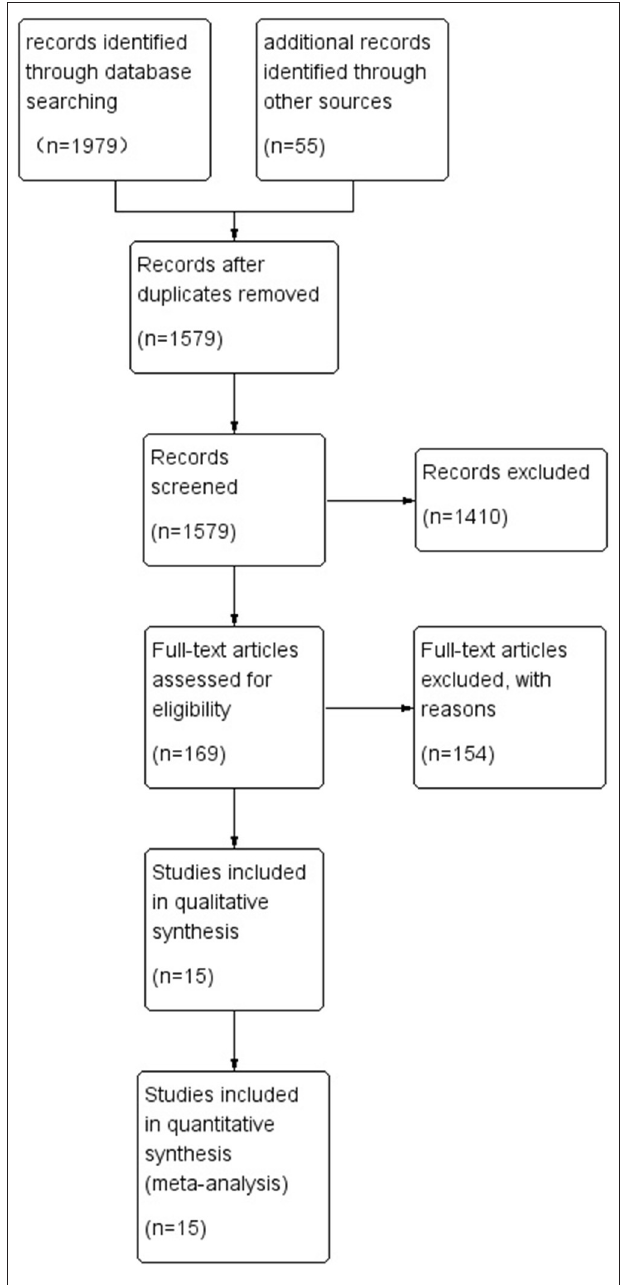
FIGURE 1 | Flow diagram of the study